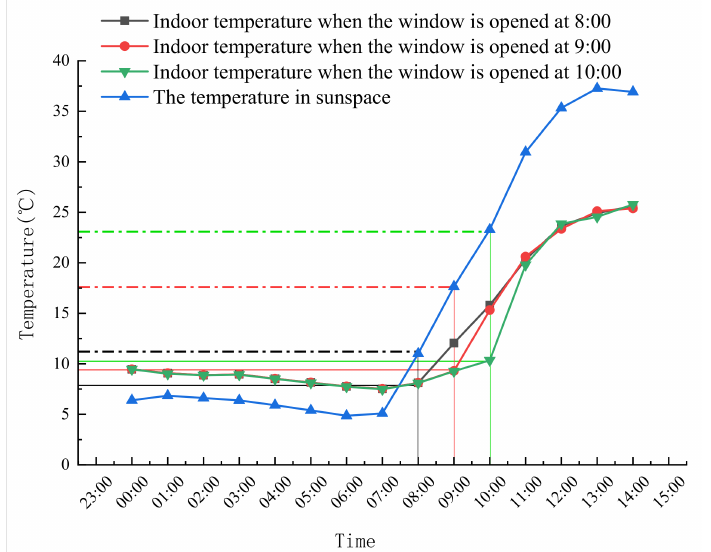
Figure 7. The temperature comparison for different window opening